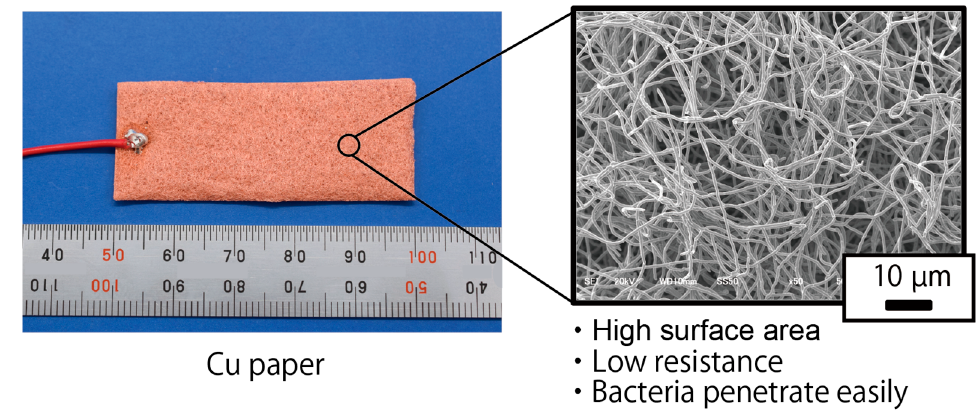
Figure 3. Image of the Cu paper.